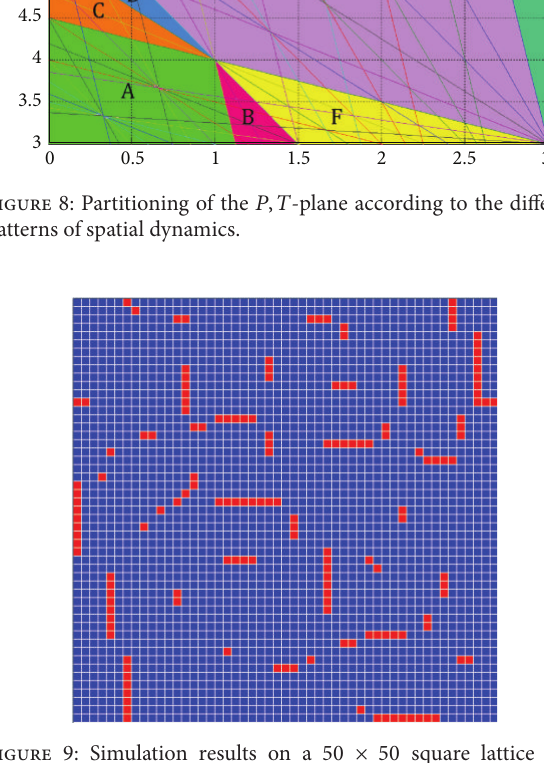
Figure 9: Simulation results on a 50 × 50 square lattice with Moore neighborhood and self-playing. The initial distribution of cooperators and defectors is randomly generated. The pattern is performed by the parameters region 𝑢 𝑖 0 < 𝑢 𝑖+2 1 (𝑖 = 1,2,...,6) .